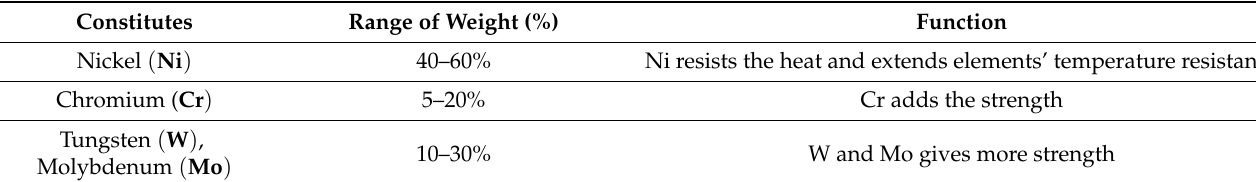
Table 2. Combinations of cobalt-based